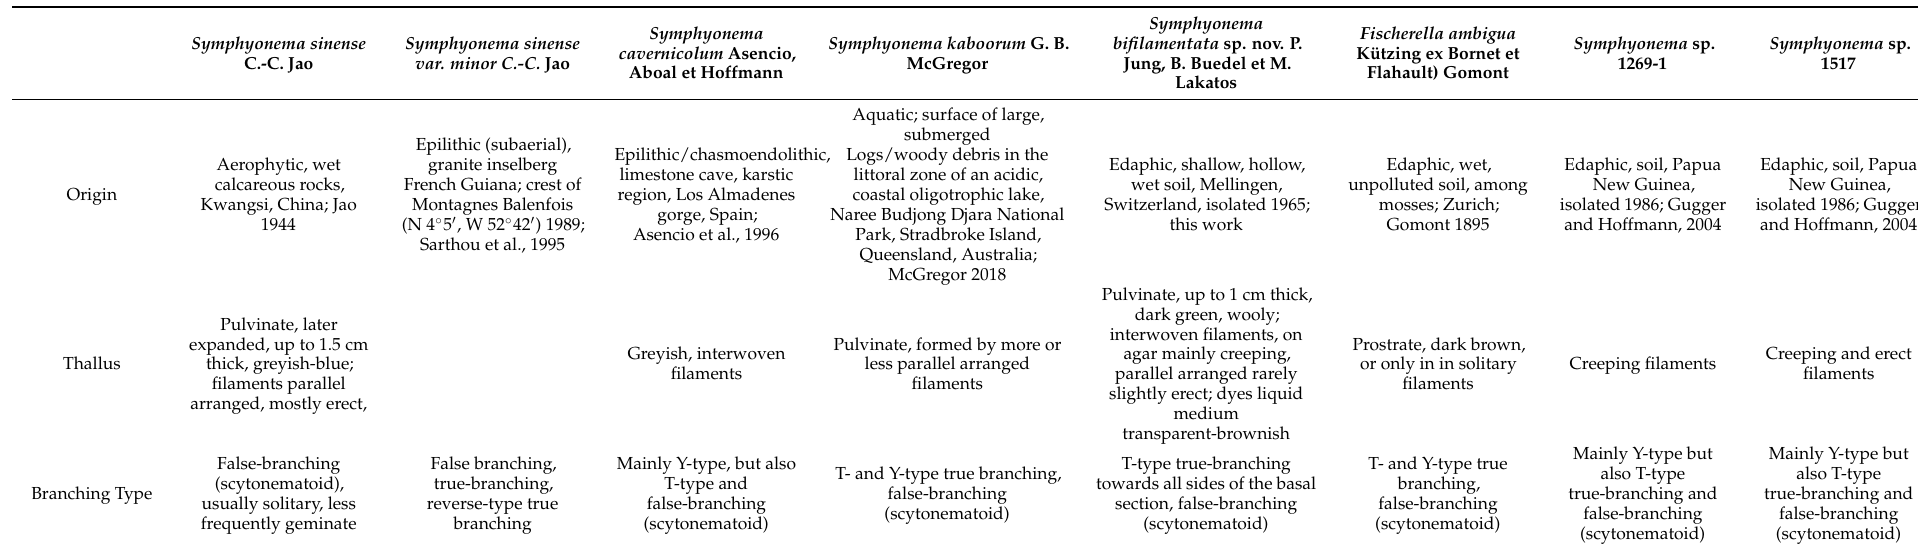
Table 1. Morphological comparison of Symphyonema species including Fischerella ambigua